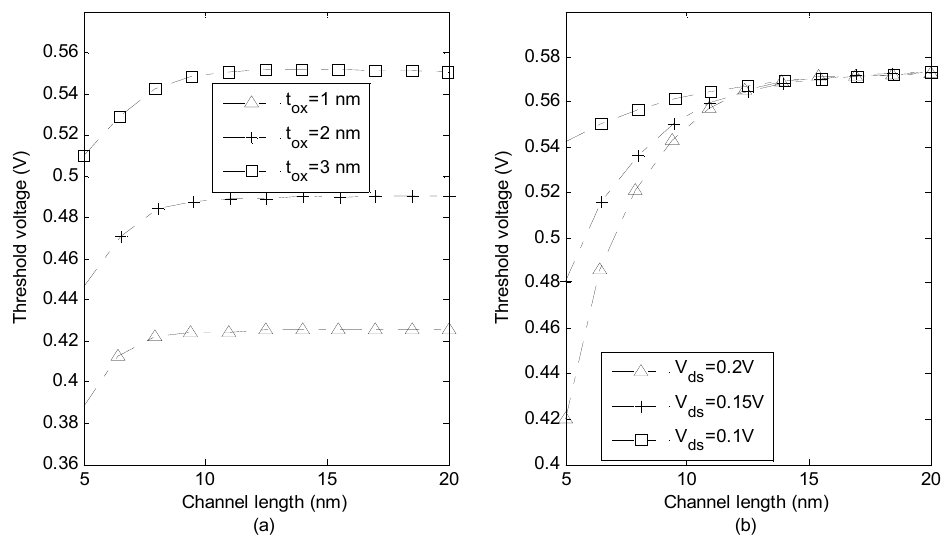
Figure 5. ( a ) Threshold voltage versus channel length for different values of ( a ) oxide thickness ( b ) drain-source voltage.